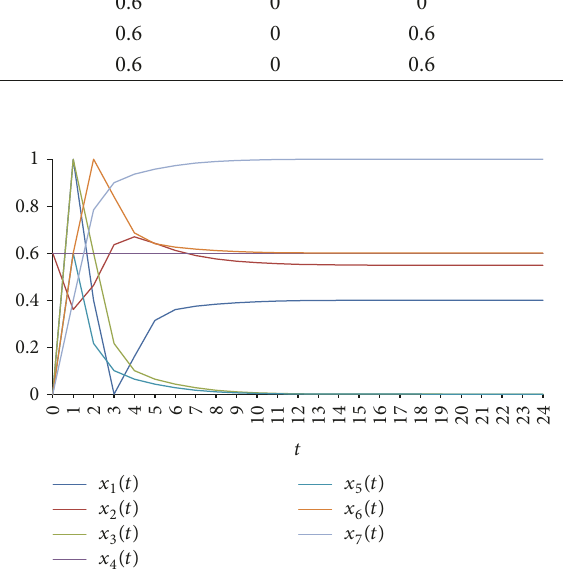
Figure 5: Dynamics of the IBN model for WNT5A gene regulation with initial stateconditions 𝑋(0) = [0; 0.6; 0;0.6; 0; 0; 0] and product operator used as 𝑡 -norm. The IBN model reaches the point attractor in 22nd iteration 𝑋(22) = [0.4;0.69; 0;0.6; 0; 0.6; 1] .